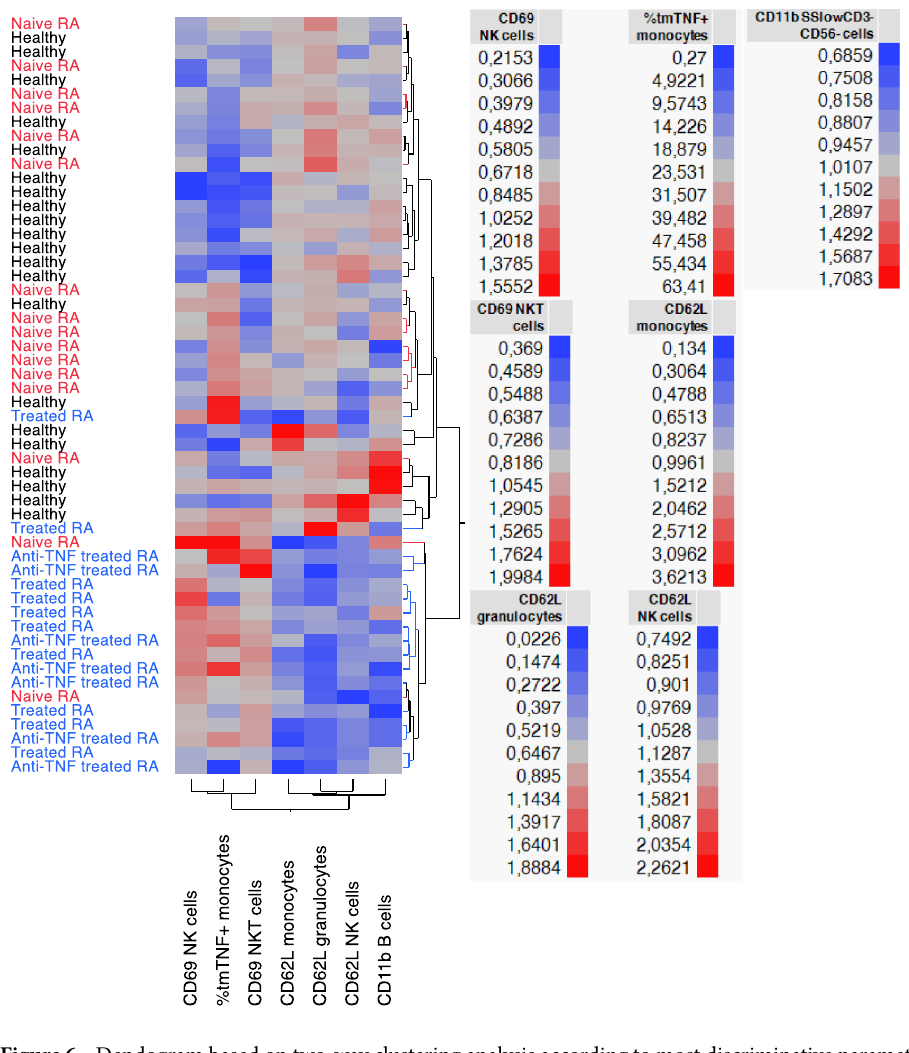
Figure 6. Dendogram based on two-way clustering analysis according to most discriminative parameters between healthy, naïve and RA treated patients. Unsupervised hierarchical clustering was performed considering healthy (black) naïve (red) and treated or anti-TNF treated patients (blue) RA patients where each row represents one donor. Legend is displayed for each parameter on the figure side.